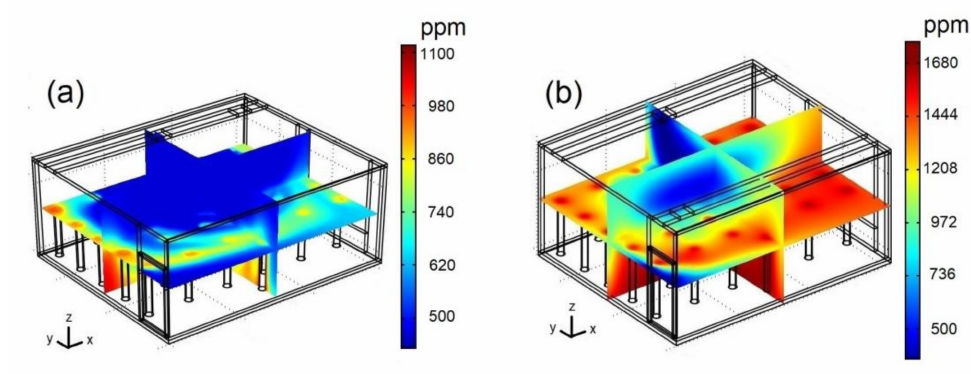
Figure 7. CO 2 concentration fields for: ( a ) case III; ( b ) case IV. Re = 15,000, 3:30 p.m. and C s = 37,500